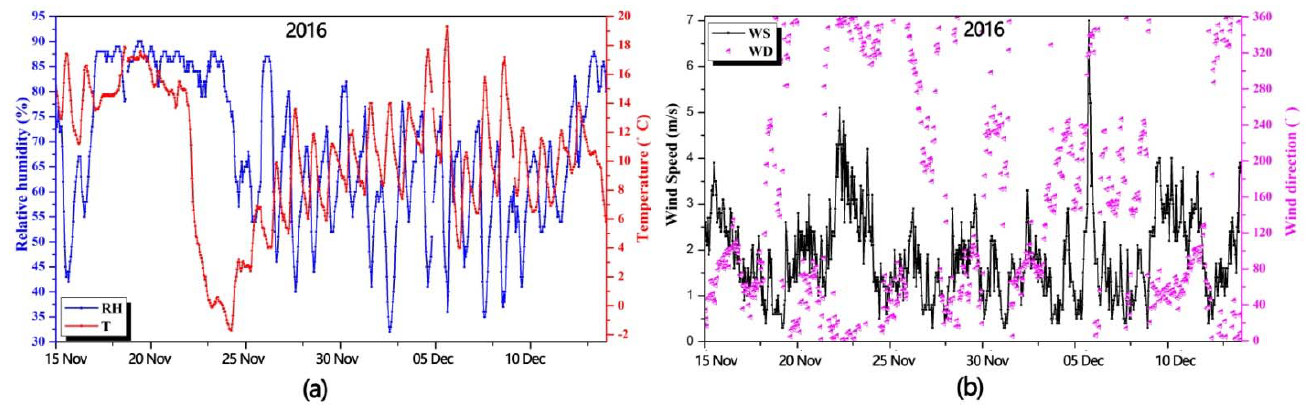
Figure 3. Time series of hourly ( a ) temperature and relative humidity and ( b ) wind speed and wind direction.